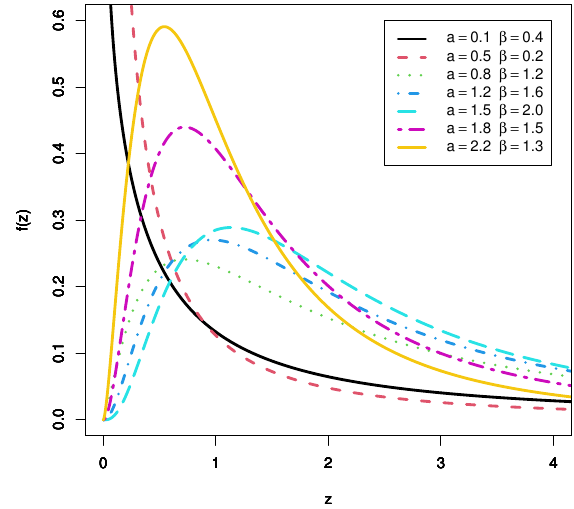
Figure 1. PDF for the TCP-ITL distribution.